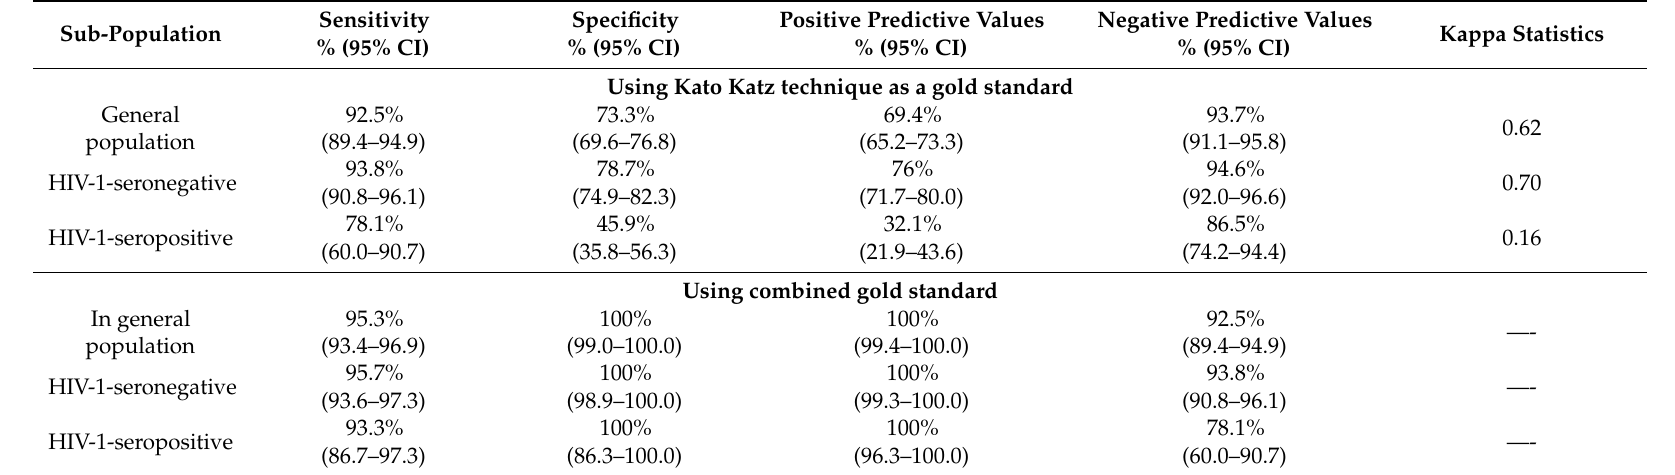
Table 4. Sensitivity and specificity of point-of-care circulating cathodic antigen test using the Kato Katz technique and a combined gold standard in sub-populations of study participants.